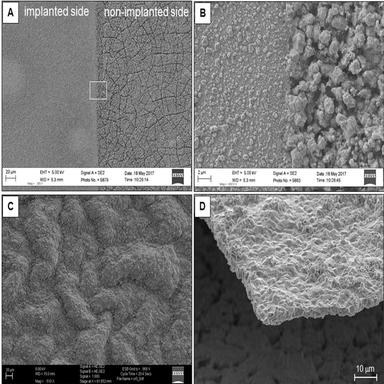
(A) - Surface morphology of the scale formed on chromium with one side having undergone yttrium implantation (2 × 1016 Y/cm2 ) after 100 h of oxidation in air at 1073 K; (B)- Fragment indicated by the white rectangle in A at a higher magnification; (C) - Surface morphology of the scale formed on the side which had not undergone ion implantation; (D) -Scale fragment which did not adhere to the part of the material which had not undergone implantation, illustrating the lack of contact with the meta